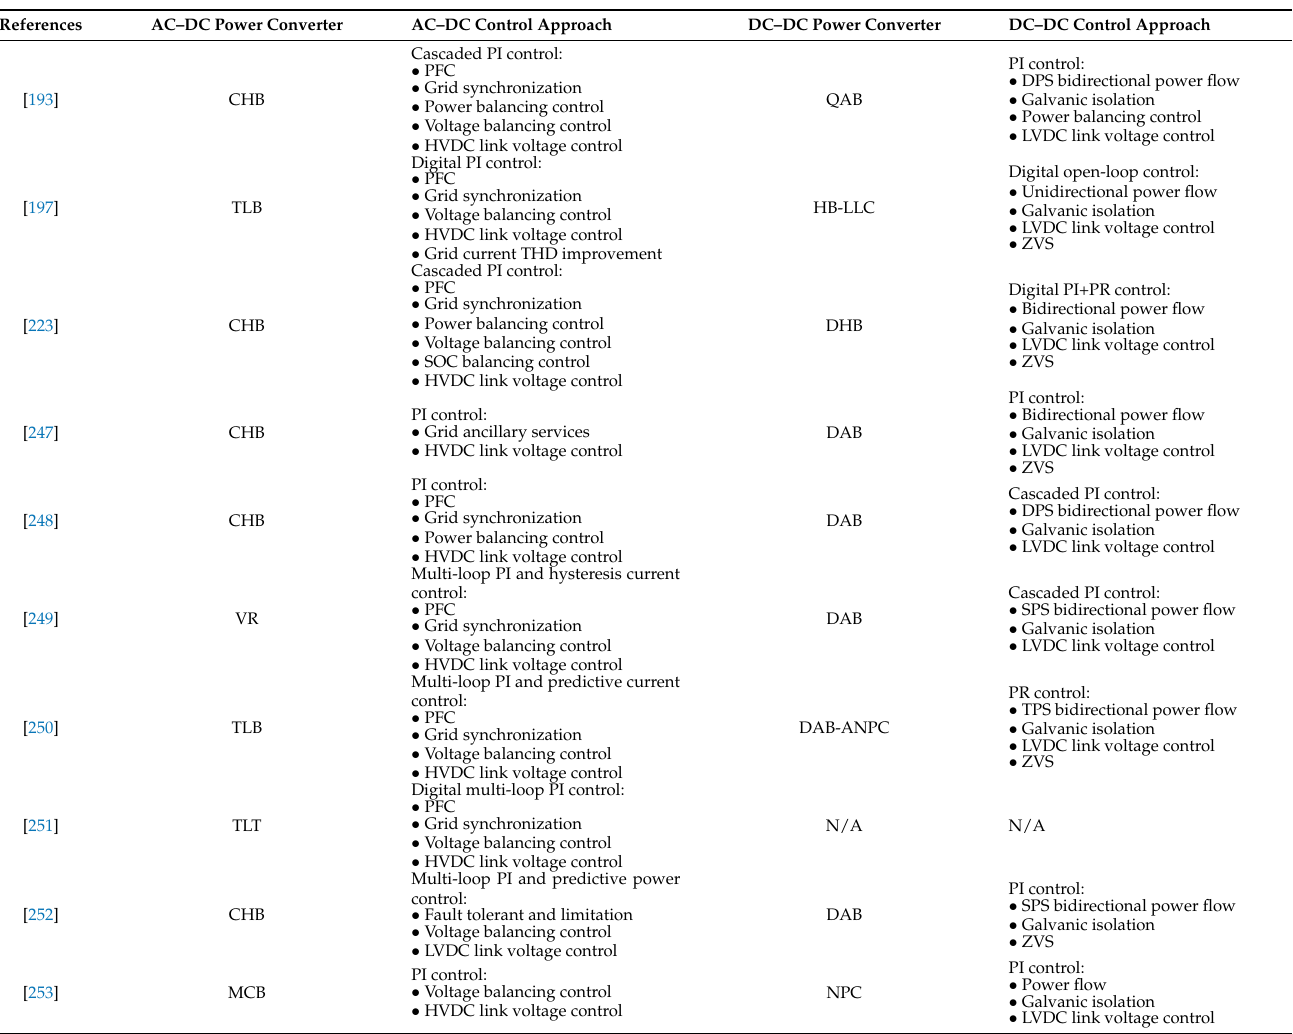
Table 6. Literature control approaches of DC SST-based ultra-fast charging